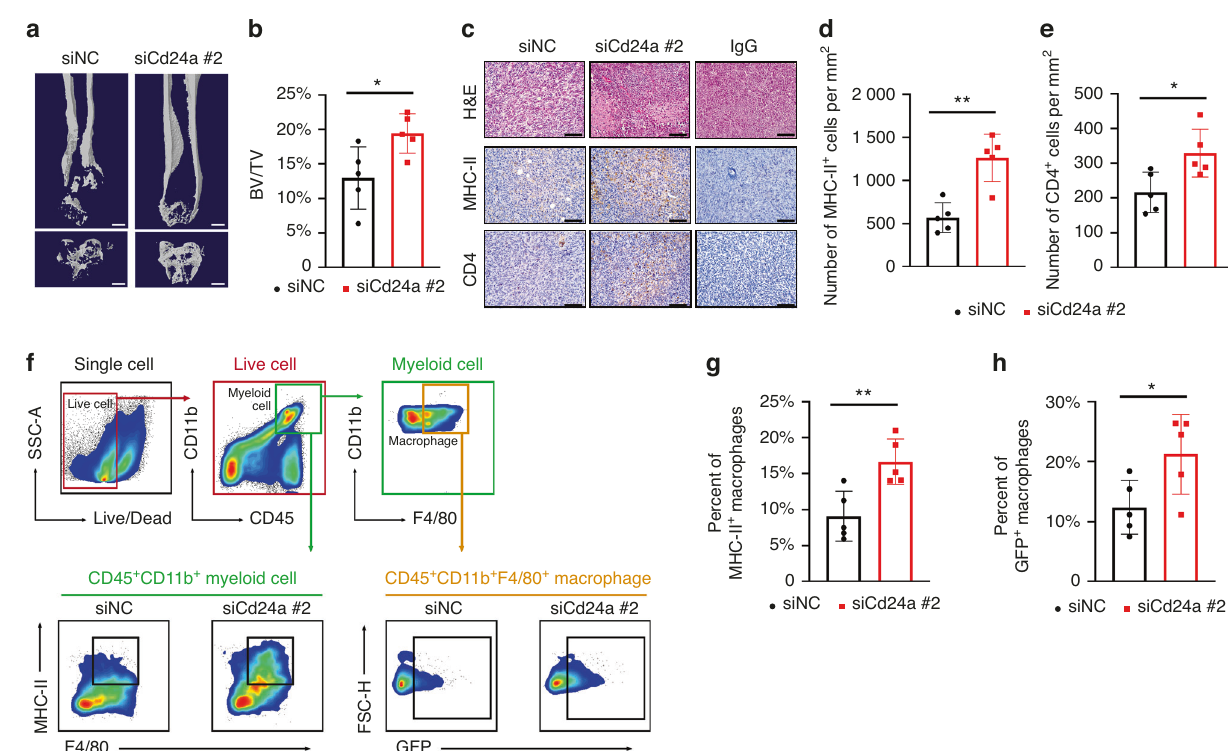
Fig. 6 Interference with the expression of Cd24a promotes phagocytosis and the M1-like phenotype of macrophages in vivo. a , b Representative images and analysis of micro-CT scanning of the distal femur in each group. Scale bar, 1 mm. BV, bone volume; TV, total volume. c – e Representative images and analysis of IHC staining of MHC-II and CD4 in tumors treated with cholesterol-modi fi ed Cd24a siRNA or scramble siRNA. Scale bar, 100 μ m. f – h Representative images of the gating strategy and statistical analysis for the in vivo phagocytosis assay and M1-like macrophage assay. Data are the means ± SEMs. * P < 0.05; ** P < 0.01; *** P <